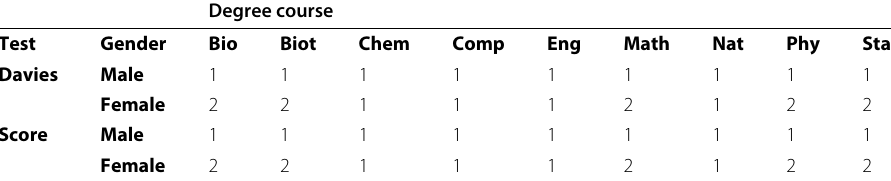
Table 4 Number of selected changepoints by gender and degree course of enrolment Degree course